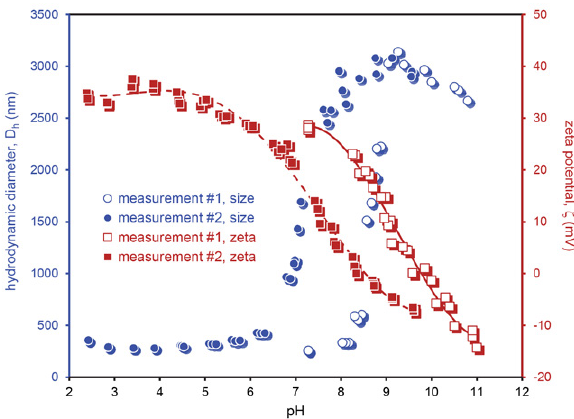
Figure 5: pH dependence of zeta potential and particle size for a dispersion of 0.01% V/V MNPs in dH 2